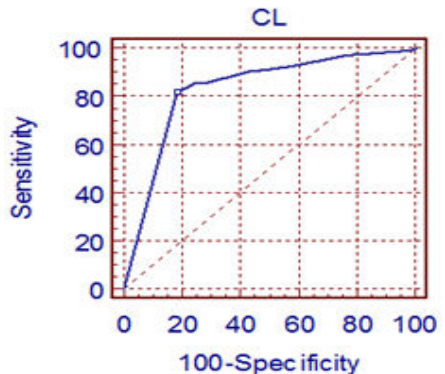
Fig. 1. ROC curve sensitivity of microbiological parameters to determine optimal cutoff point